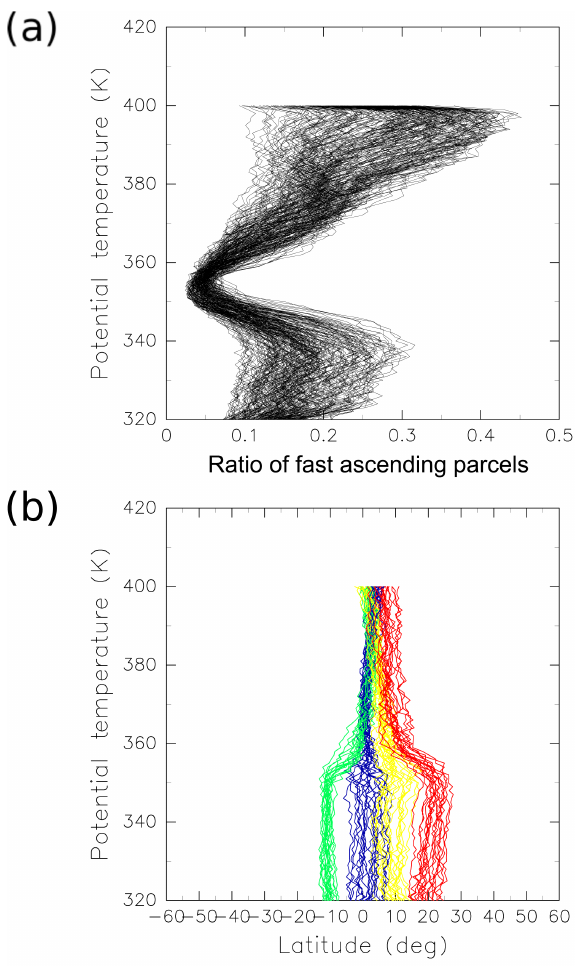
Figure 2. The vertical profiles of (a) proportion of the “fast” as- cending air parcels and (b) averaged ascending track diagnosed by 90-day kinematic back trajectories that extends from 400K to the lower troposphere below 340K potential temperature surface. The upward motion on θ K isentrope is categorized as “fast” if the air parcel crosses θ K surface from below θ − 0 . 1K to above θ + 0 . 1K in 30min. Each line in (a) shows the daily proportion of trajecto- ries at each isentropic level that correspond to “fast” ascending air parcels. The ascending tracks in (b) are color-coded on a monthly basis (January in blue, April in green, July in yellow, and October in red) to visualize the seasonal migration of the ascending latitude in the tropics.